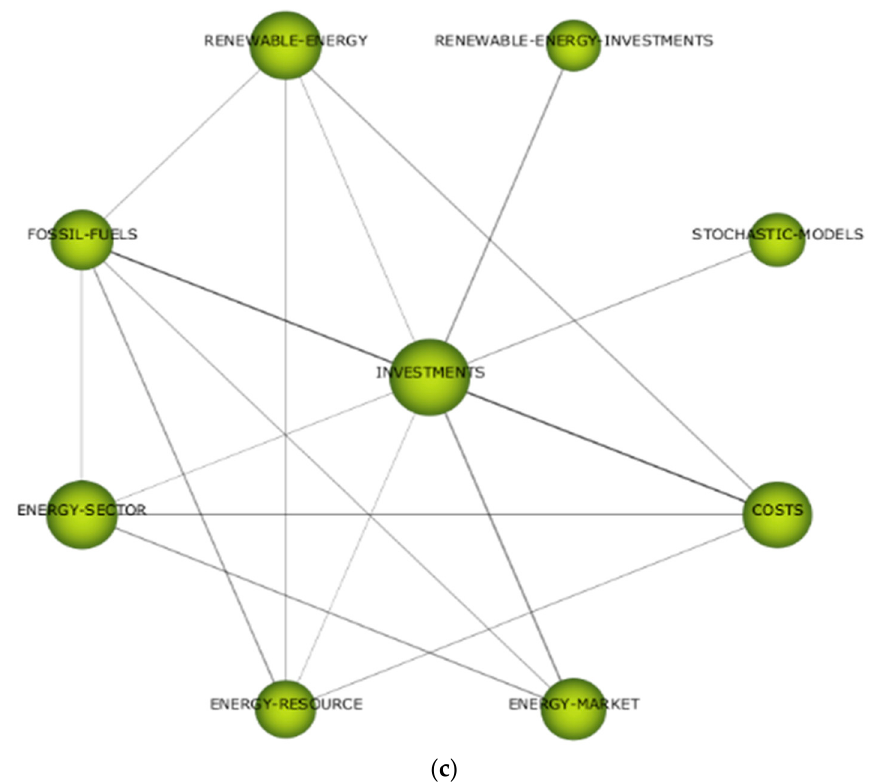
Figure 7. Major theme ( a ) and thematic network ( b , c ) of the third sub-period (2011–2015). Note: Clusters information: ACCIDENTS (centrality: 21.22; density: 26.1); INVESTMENTS (centrality: 13.17; density: 20.52); CRITICAL-FACTORS (centrality: 0.65; density: 100); SUSTAINABLE-DEVELOPMENT (density: 5.93; density: 8.08); GREENHOUSE-GASES (centrality: 0.14; density: 33.33); ALGORITHM (centrality: 0.65; density: 22.22); CONSTRUCTION-FIRMS (centrality: 0.87; density: 16.67). Node size is proportional to the number of papers; the number in a node denotes the number of papers related to a node topic. See Section 2.2 for description of the quadrants. Table 6. Cluster information and key parameters—sub-period (2011–2015).